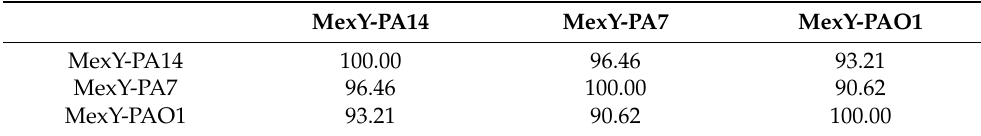
Table 1. Identity matrix (% percentage) for polymorphic MexY proteins in P. aeruginosa PAO1, PA07, and